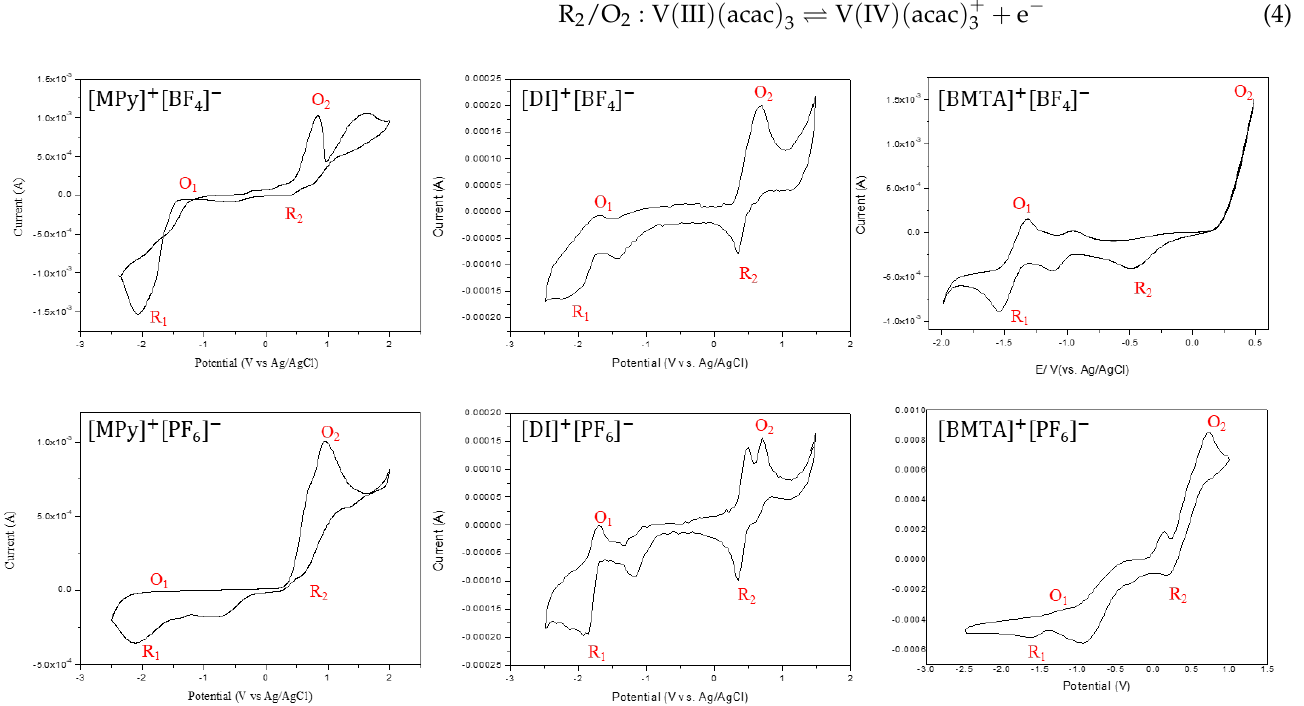
Figure 4. Cyclic voltammograms (CV) of 0.01 M V(acac) 3 under acetonitrile with 0.1 M aromatic N-heterocyclic salts on a glassy carbon working electrode with a scan rate of 100 mV/s.